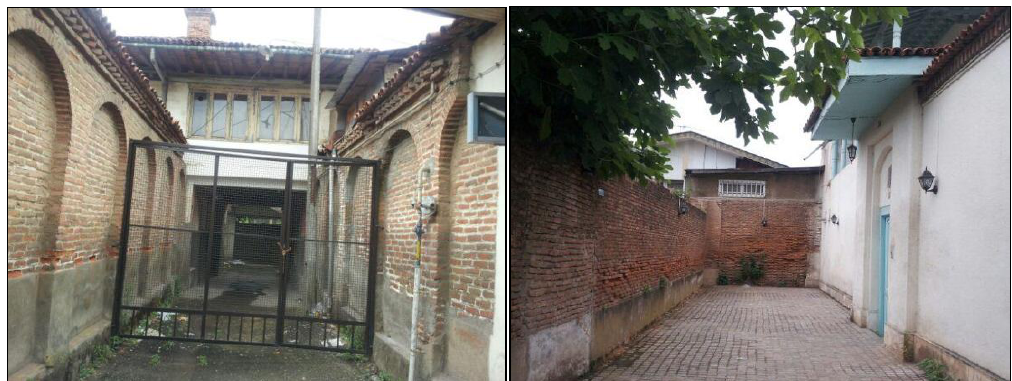
Figure 4. Private Alleys of the Texture Figure 5. Private Alleys of the